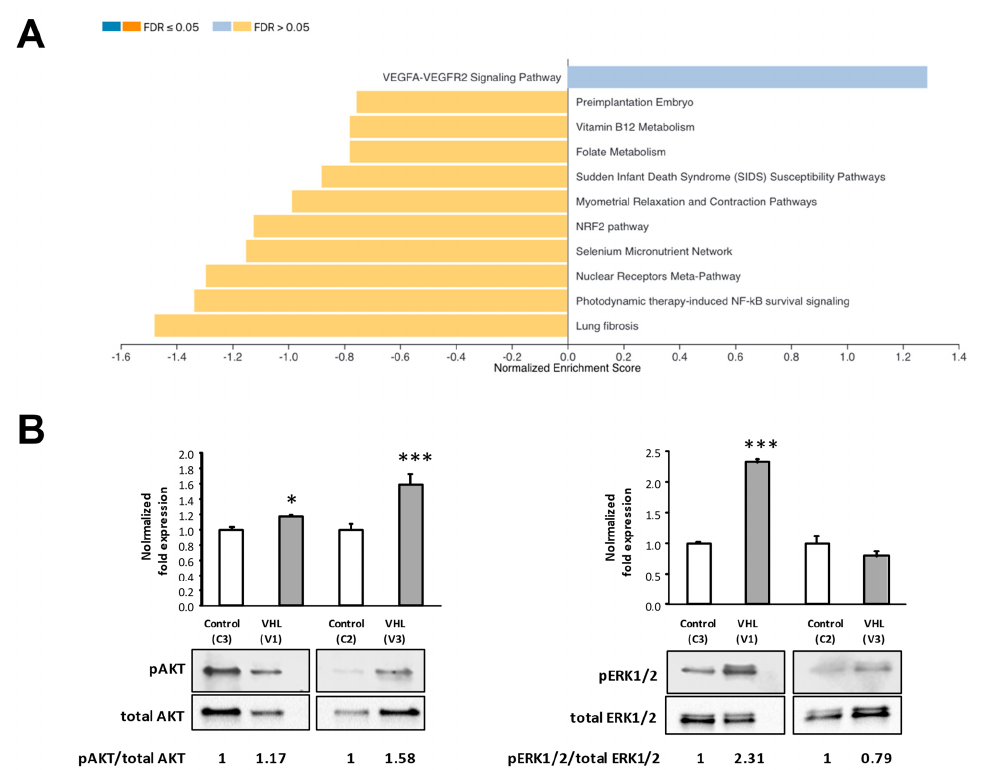
Figure 6. ( A ) VEGF signaling pathway appeared upregulated, according to the GSEA analysis. ( B ) ERK1/2 and AKT phosphorylation assessment by Western Blot. Densitometric quantification of phosphorylated/total protein ratios are shown for control subject ( n = 2) or VHL patients ( n = 2). Error bars denote ± SEM. Student’s t -test: * p < 0.05 and *** p < 0.001.